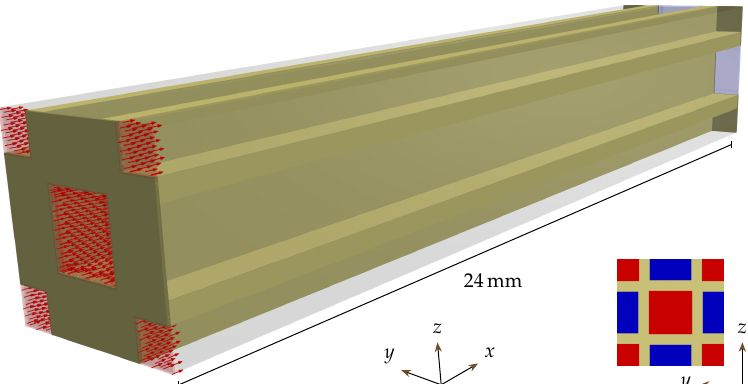
Figure 1. Channel model, including one central inflow channel and fractions of surrounding inflow and outflow channels. Dark yellow structures represent porous filter substrate, brown structures solid walls. Red colouring indicates inflow sections, blue colouring indicates outflow